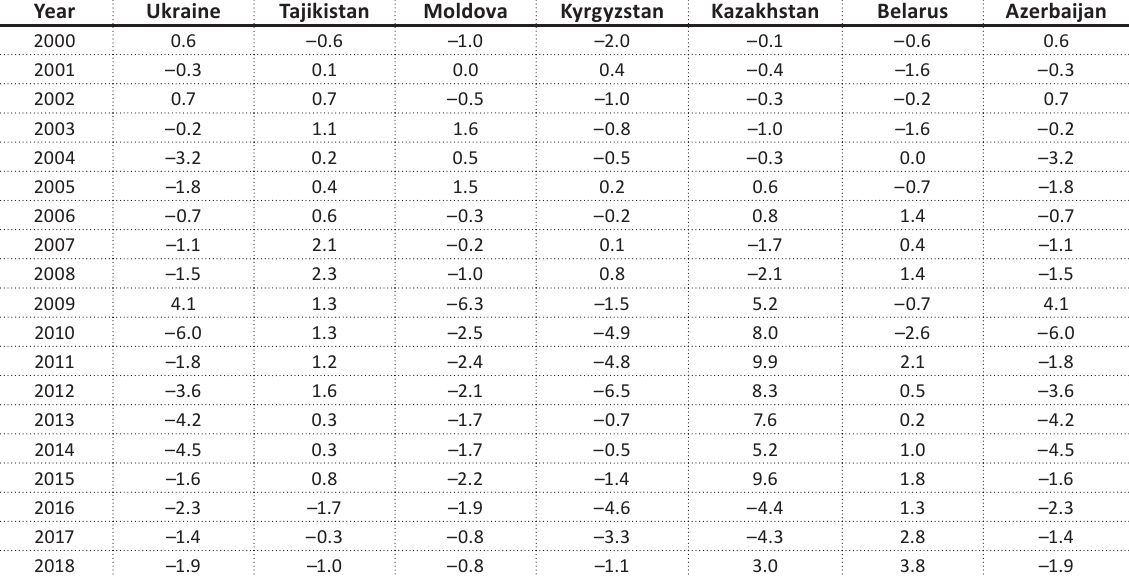
Table 1. The share of the consolidated budget deficit in GDP,